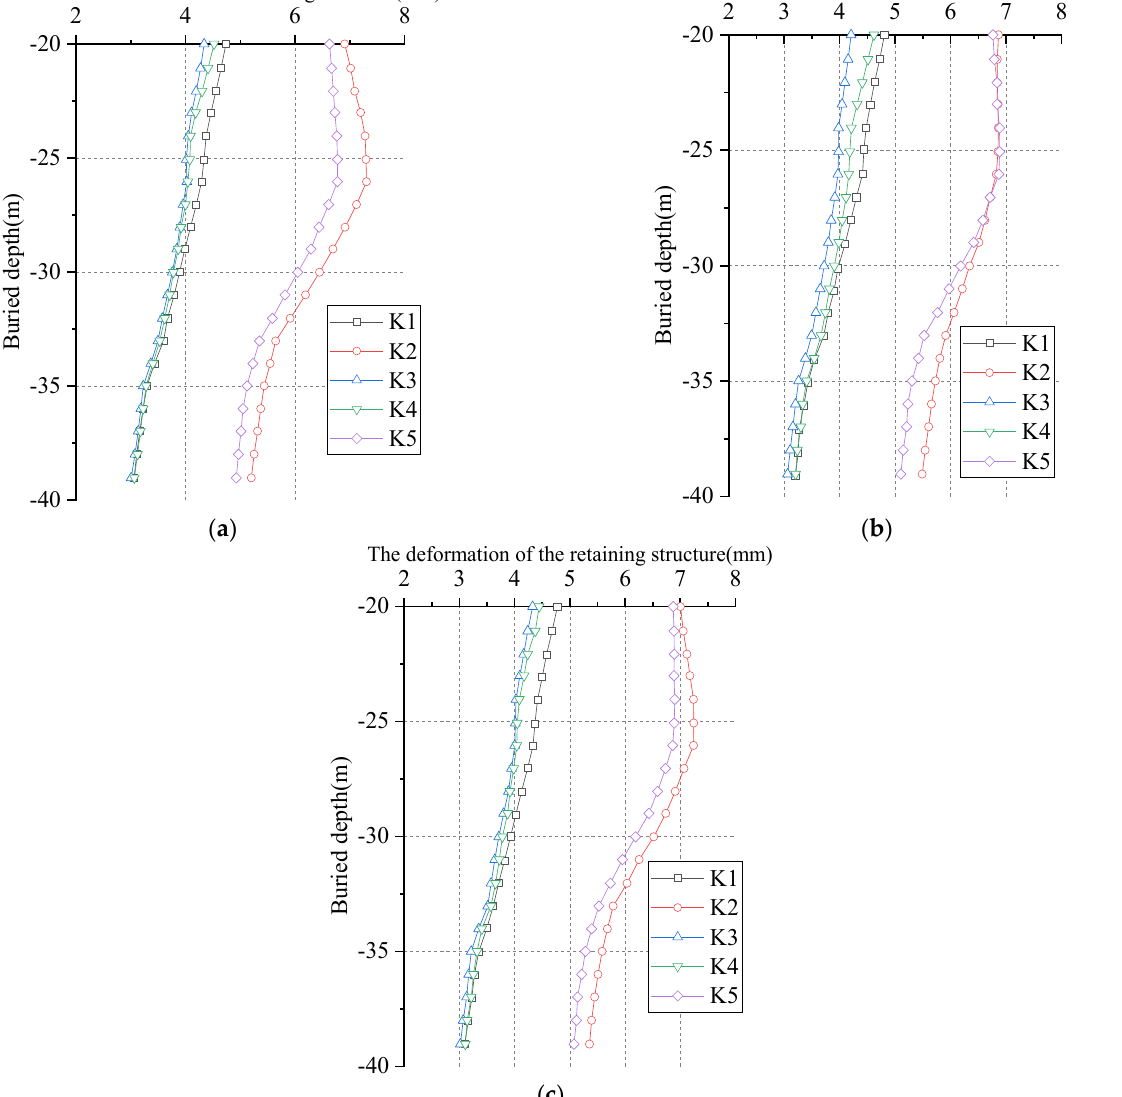
Figure 13. Retaining structure deformation in pit-in-pit district. ( a ) working Condition 1. ( b ) working Condition 2. ( c ) working Condition